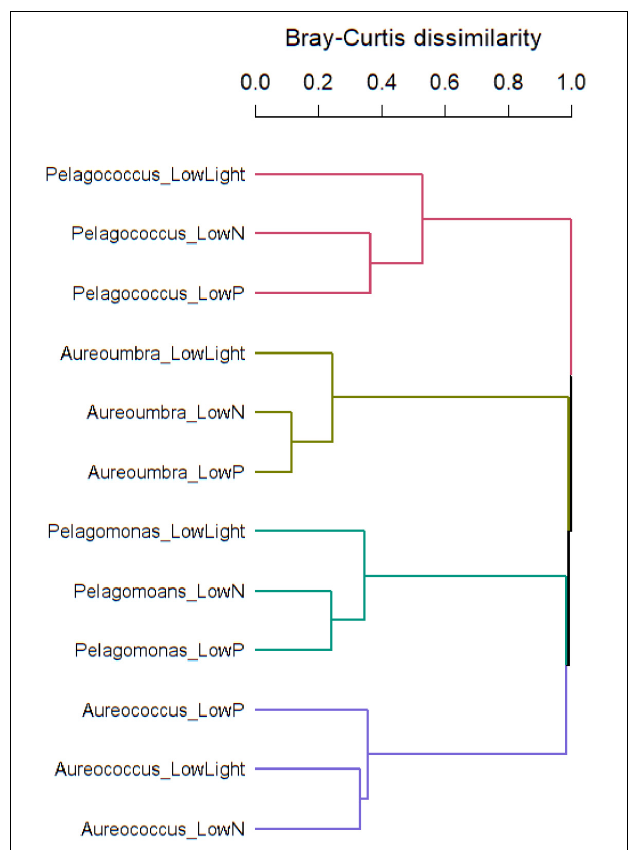
FIGURE 3 | Bray-Curtis dissimilarity of OGs in response to treatments showing dissimilarity among four